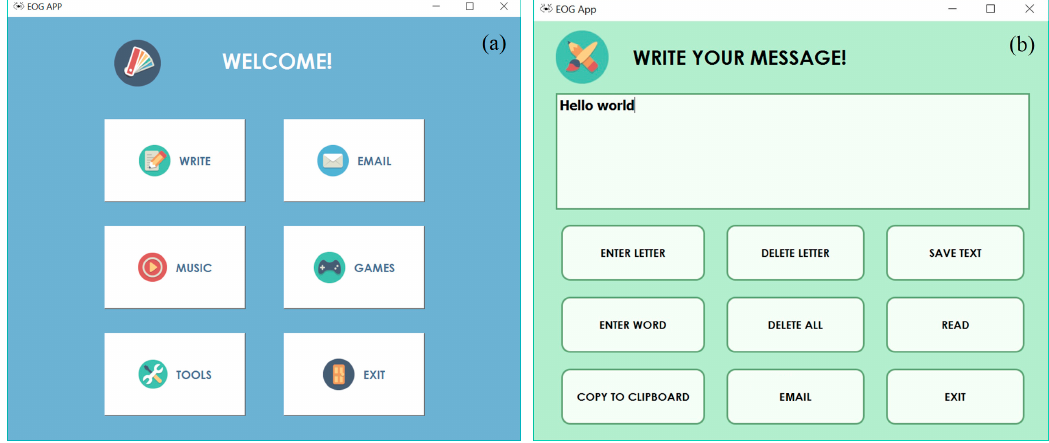
Figure 6. ( a ) Main menu of the application; ( b ) Writing module.